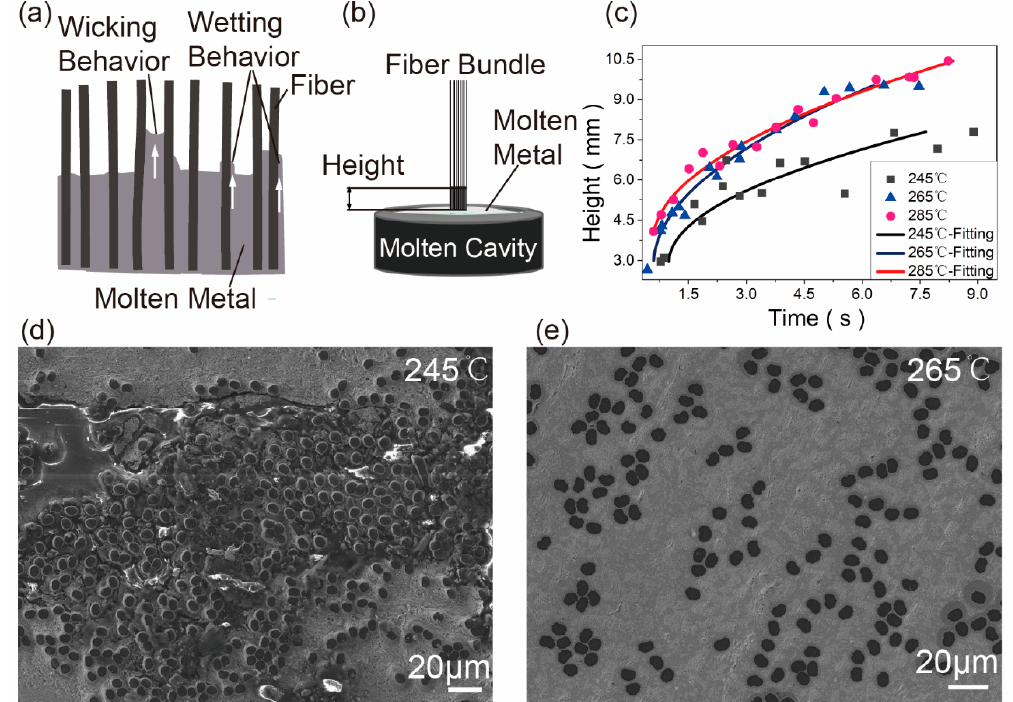
Figure 7. Wicking performance tests of CF/Pb50Sn50. ( a ) Mechanism of wicking and wetting behavior; ( b ) Schematic illustration; ( c ) Wicking performance of fiber bundles at 245 °C, 265 °C and 285 °C; Internal structure of composites printed at ( d ) 245 °C and ( e ) 265 °C.